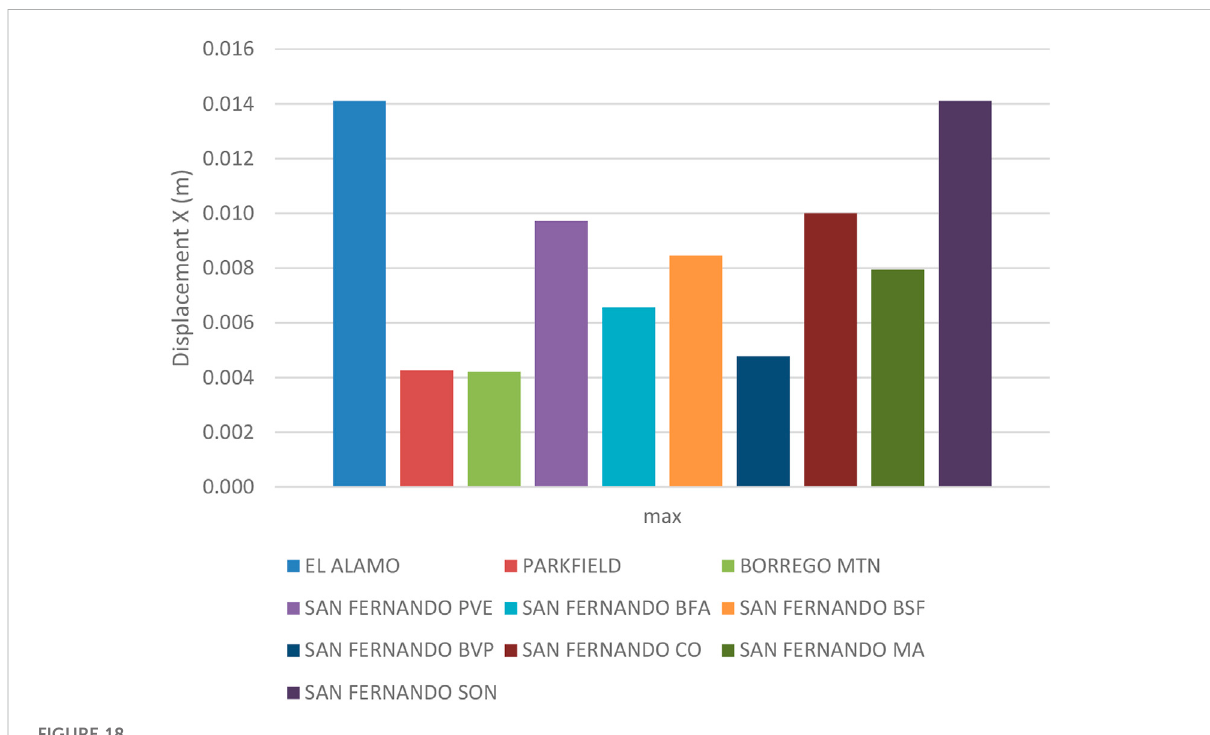
FIGURE 18 Displacement in